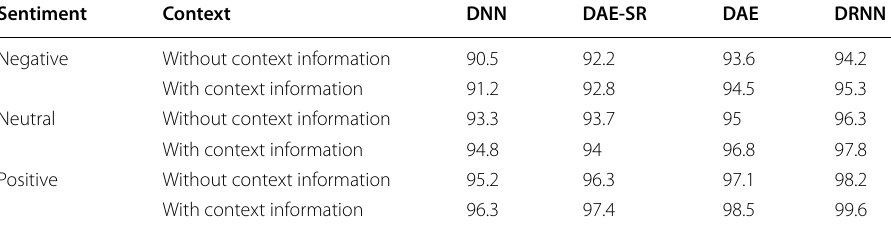
Table 9 Evaluation of accuracy using various sentiment with context information